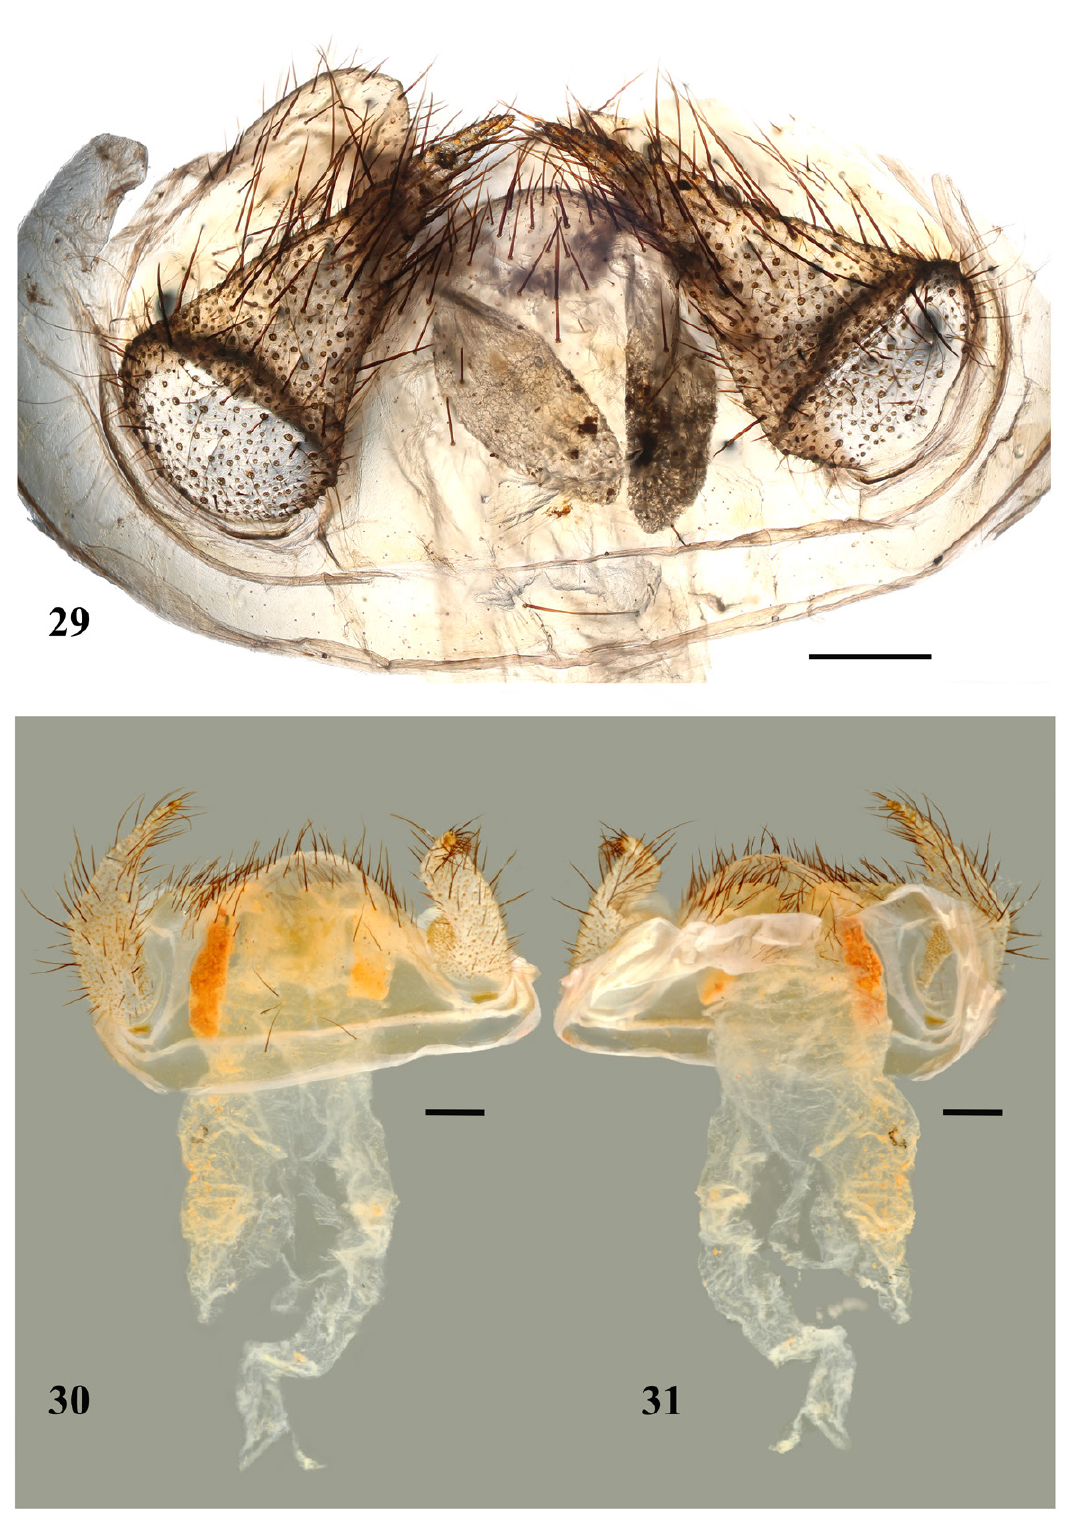
Figs 29–31. Oryctopterus varuna sp. nov. Paratype, ♀ (NBAIR). 29 . Supragenital plate and cerci, dorsal view (macerated specimen, through transmitted light). 30 . Supragenital plate, cerci and alimentary canal, dorsal view (macerated specimen). 31 . Supragenital plate, cerci and alimentary canal, ventral view (macerated specimen). Scale bars = 1